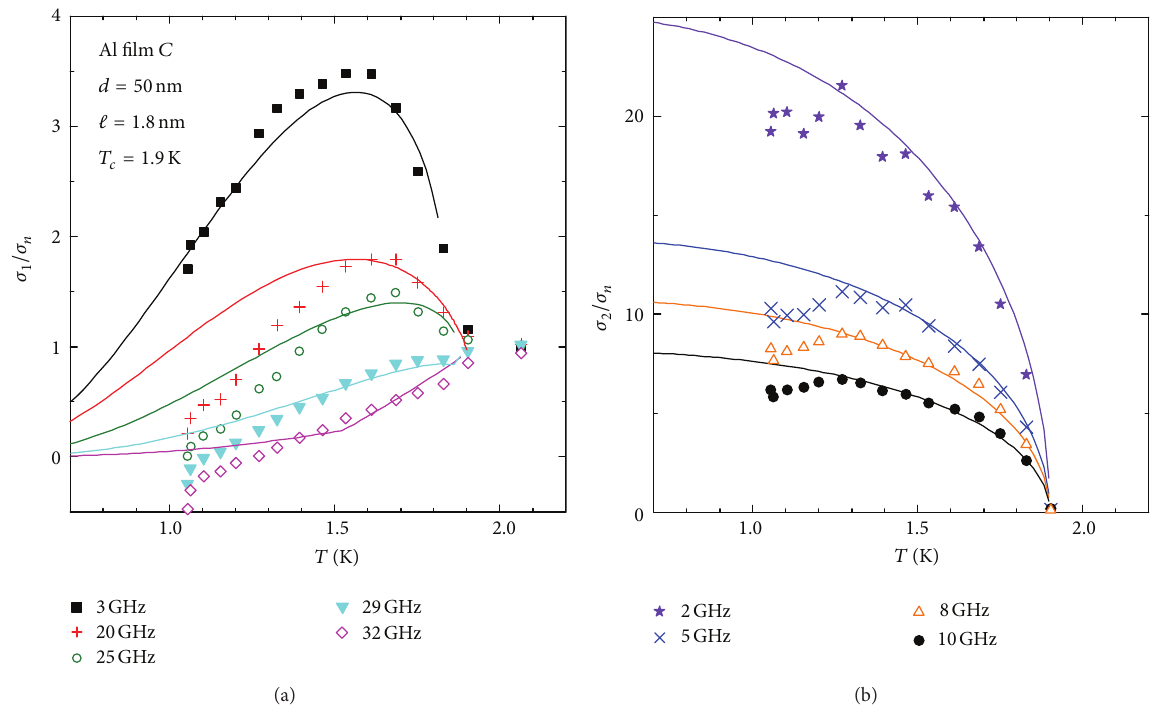
Figure 9: Temperature dependence of the (a) real and (b) imaginary parts of the conductivity of aluminum normalized to the normal state conductivity 𝜎 𝑛 for selected frequencies. The solid lines are calculated by the BCS theory using ℓ/(𝜋𝜉) = 0.03